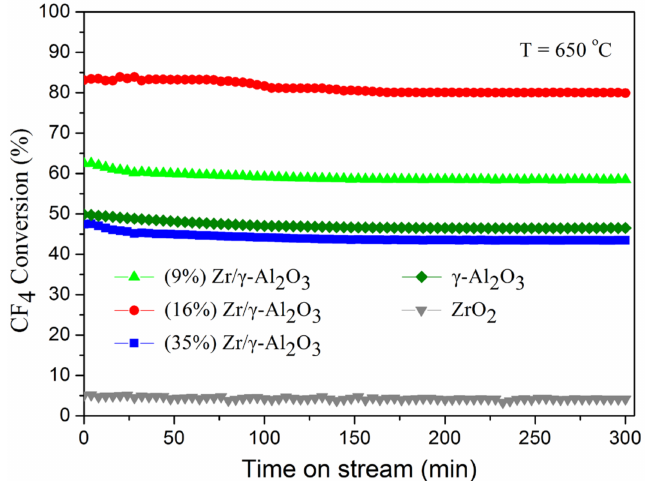
Figure 5. CF 4 conversion reaction over different loading Zr/ γ -Al 2 O 3